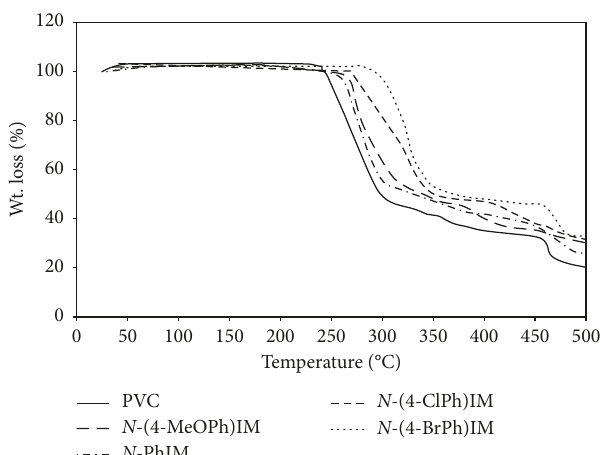
Figure 4: Thermal gravimetric analysis of PVC modified by various itaconimide derivatives as compared to PVC.